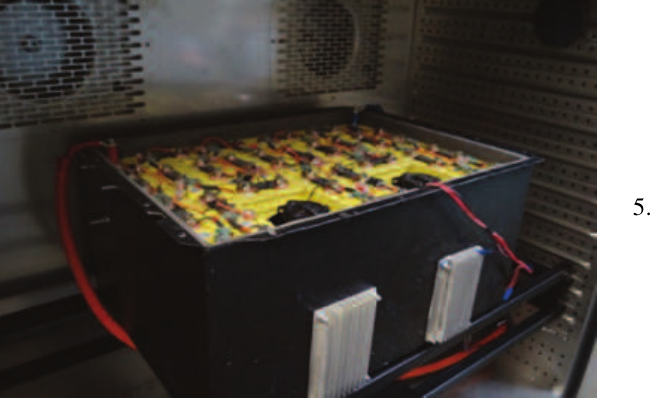
Fig. 8 Fragment tests in a heat